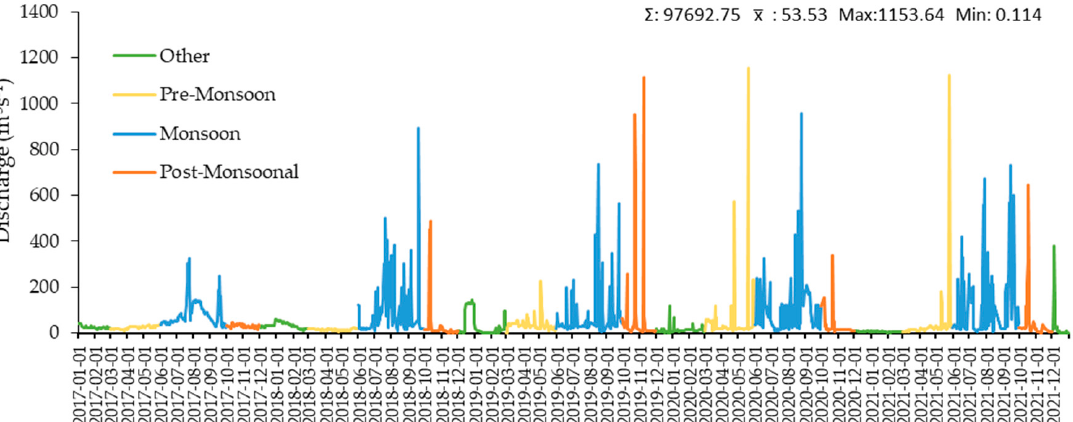
Figure 4. The simulated hydrograph of daily discharges variations on Subarnarekha river on the Delta Sub-Basin.